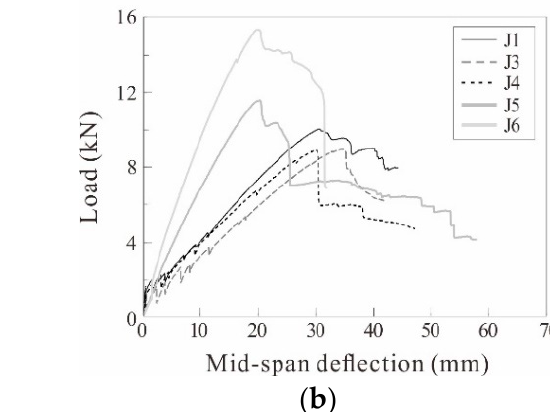
Figure 8. Damage observed in the carbon grids of specimens: ( a ) J5; ( b ) G1; ( c ) G3; and ( d ) G2.